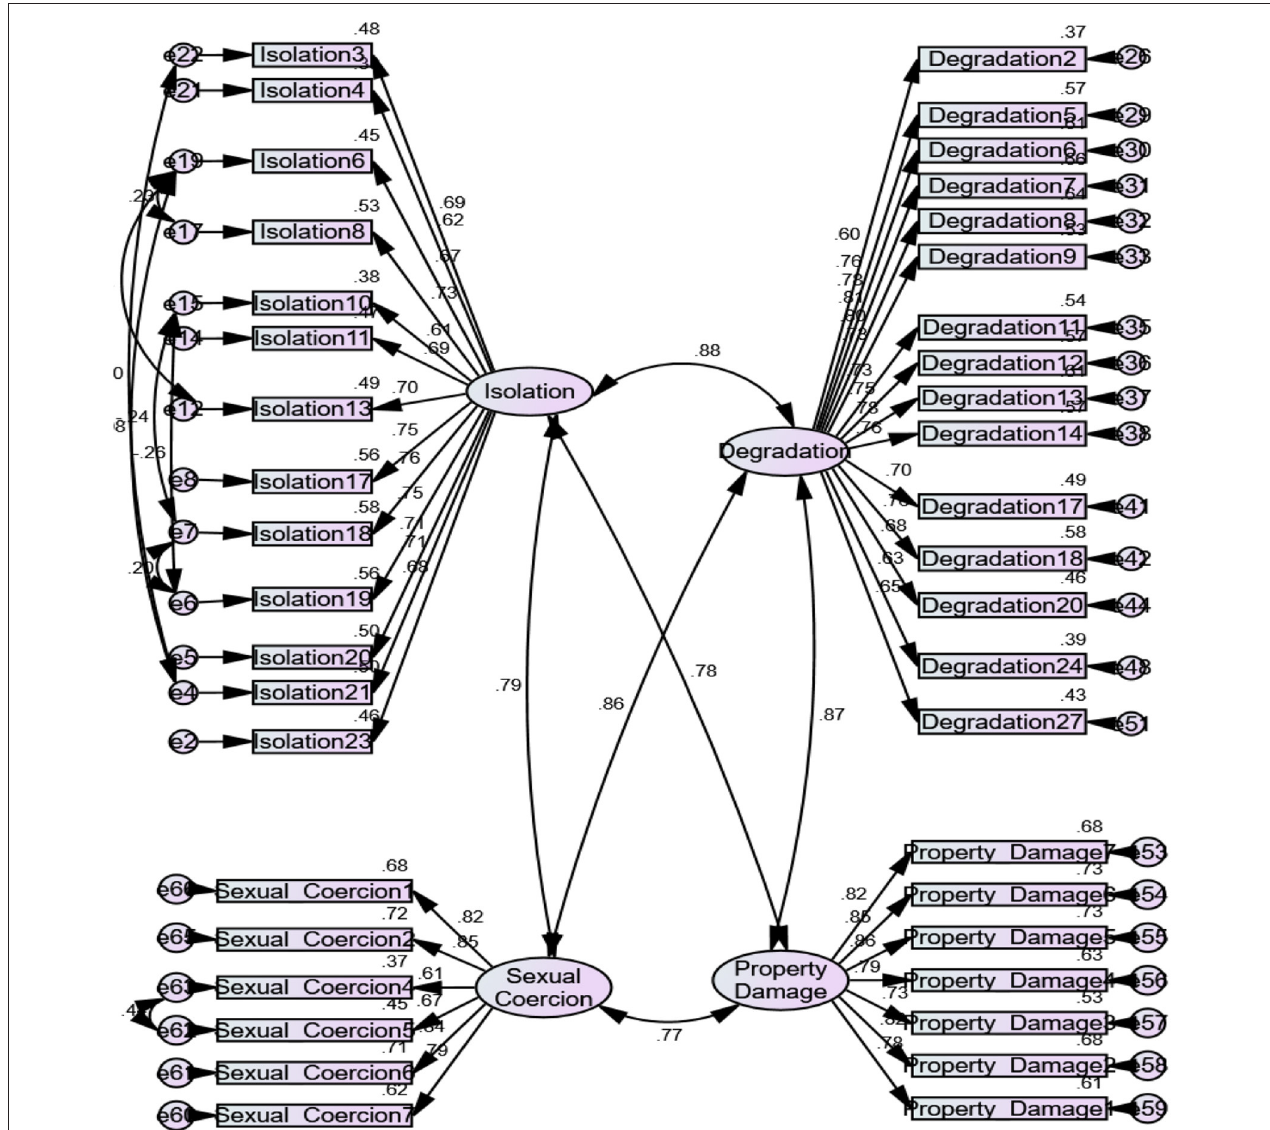
FIGURE 1 | Confirmatory factor